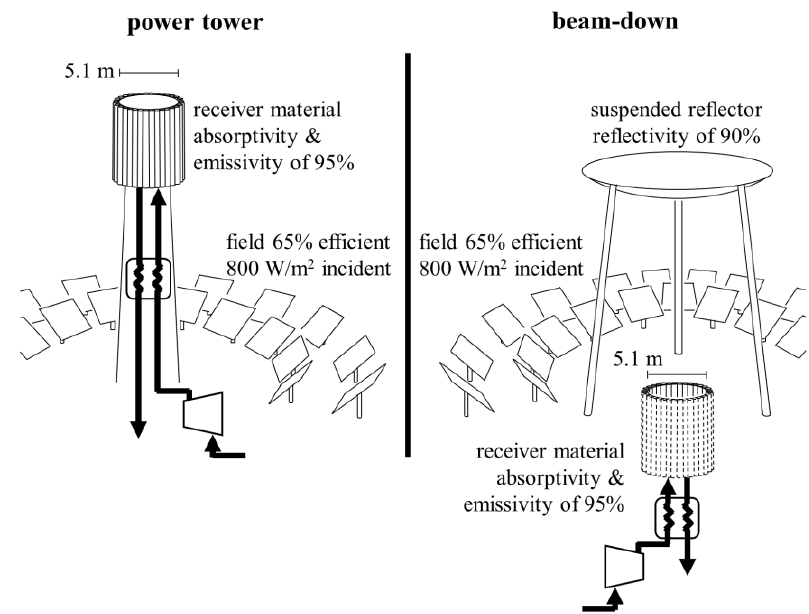
Figure 2. Characteristics of solar catalytic molten methane cracking in a “Solar Two” [14] configuration or an analogous beam-down configuration.